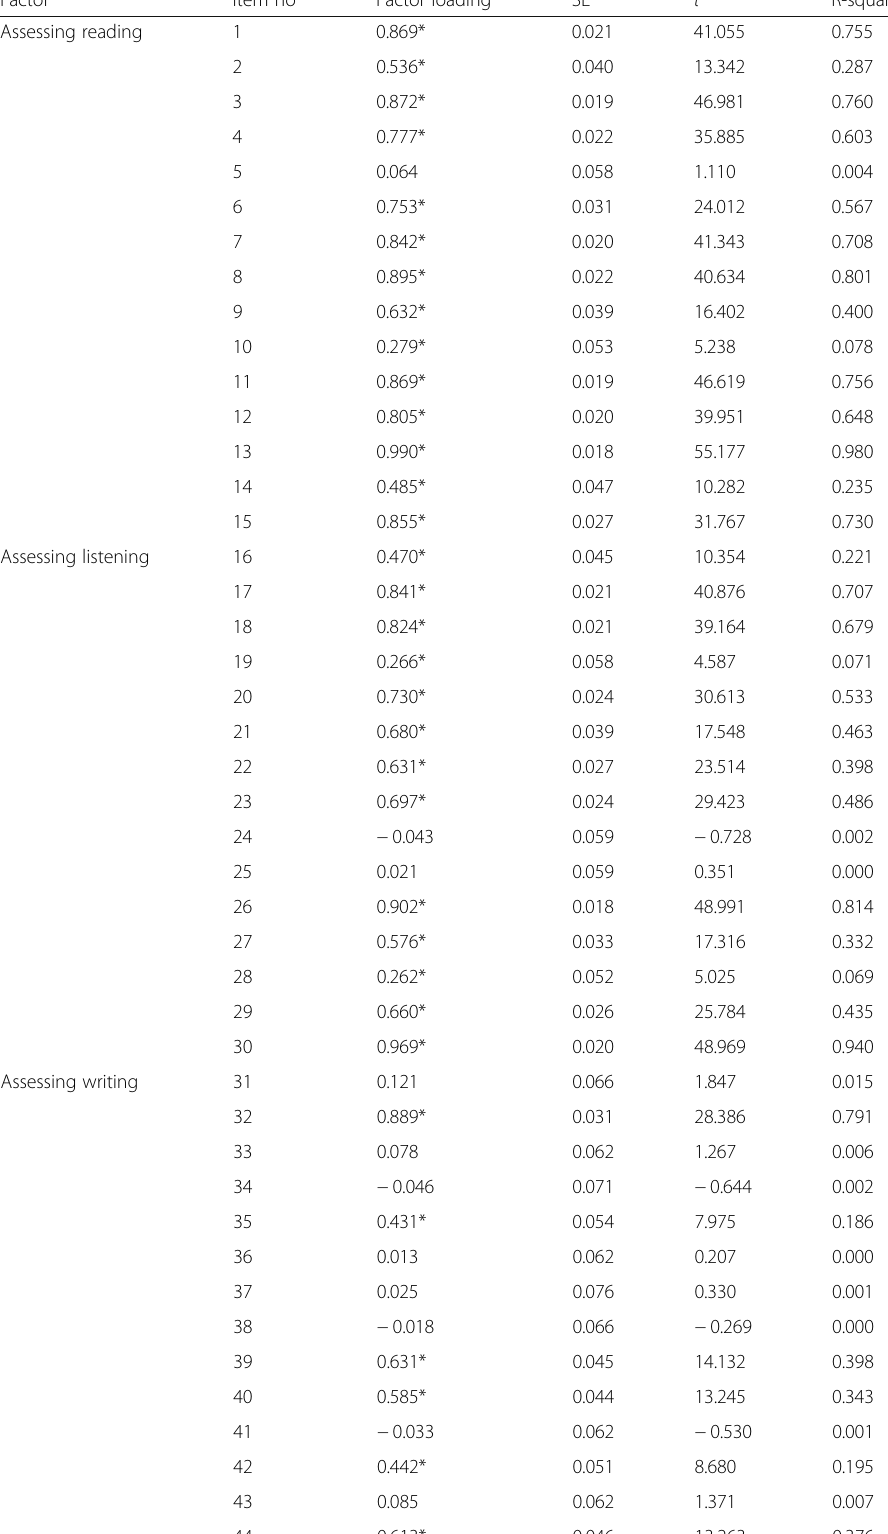
Table 4 Factor loadings for each item